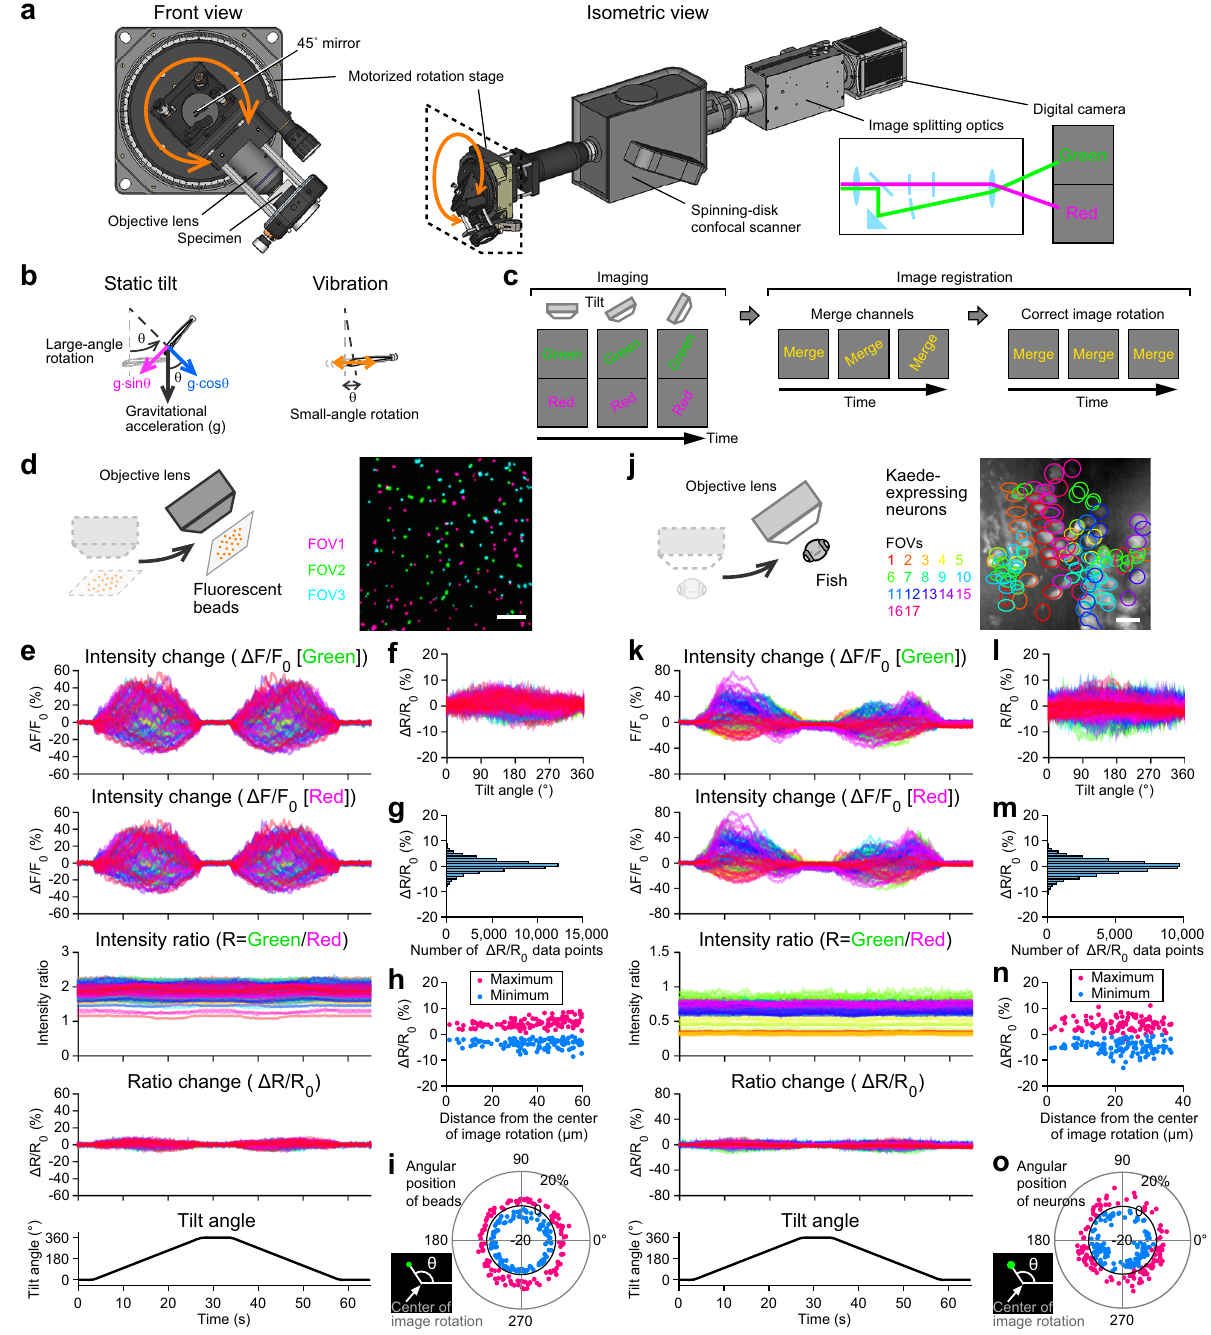
Fig. 1 | Tiltable objective microscope enables functional imaging during 360° static tilt and vibration. a Schematic showing a tiltable objective microscope. An objective lens and a specimen are tilted by a motorized rotation stage (see Sup- plementary Movie 1). b Gravitational vector components (magenta and blue arrows) during static tilt produced by large-angle, slow rotation (left). Inertial acceleration during vibration (orange arrows) produced by small-angle, fast rota- tion(right)(seeSupplementaryFig.1). c Rotatedimagesaremergedandregistered by correcting the image rotation (see Supplementary Movie 2 and “ Methods ” ). d Fluorescent beads. Images from 3 fi elds of view (FOVs) are superimposed. Scale bar: 20 μ m. e Time course of beads fl uorescent intensity changes during 360° tilt. Large fl uctuation in green and red signals is reduced in ratio and ratio change ( Δ R / R 0 ). 116 beads from 3 FOVs. f Relationship between tilt angle and Δ R / R 0 . g Distribution of Δ R / R 0 values during tilt. h Relationship between beads distance fromthecenterofimagerotation,whichisthecenteroftheimagein[ d ],and Δ R / R 0